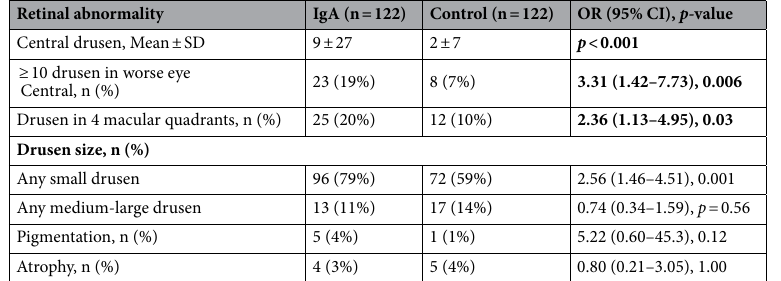
Table 2. Retinal abnormalities of individuals with IgA glomerulonephritis or controls. Central Fovea and parafovea, Peripheral perifovea and non-macular, SD Standard deviation. Significant values are in bold.